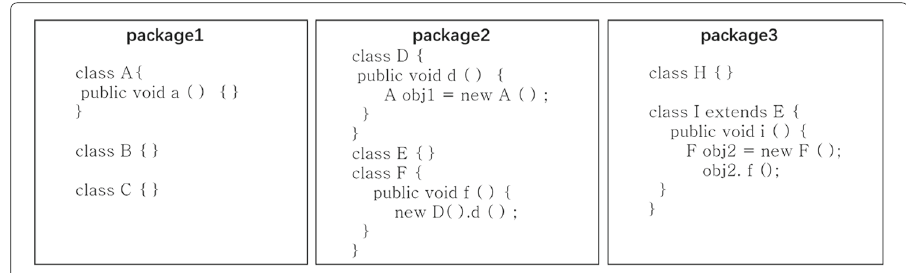
Fig. 1 An example of Java software